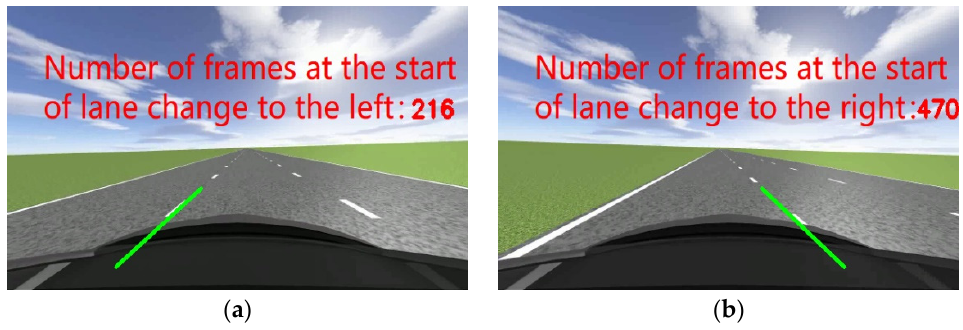
Figure 18. The start moment of the vehicle changing lane to the left and to the right as judged by the monocular camera: ( a ) The moment when the vehicle starts to change lanes to the left; ( b ) The moment when the vehicle starts to change lanes to the right.